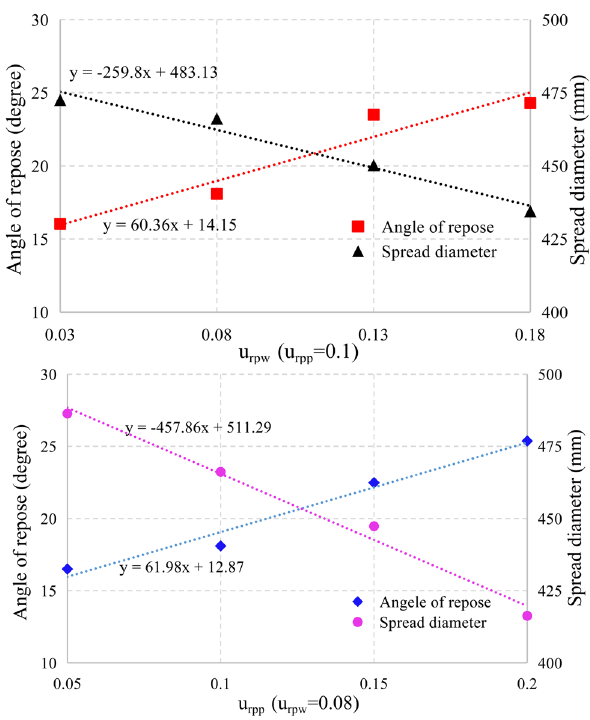
Figure 9: Variation curve of rolling friction coe ffi cient, angle of repose, and spread diameter.